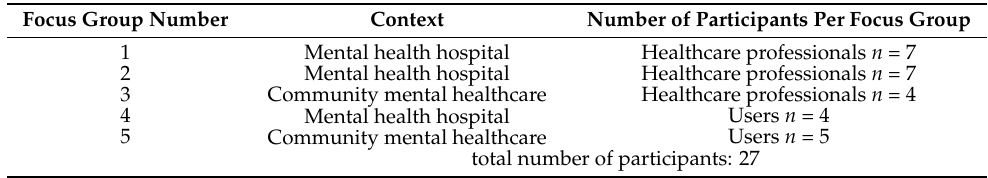
Table 1. Overview of the focus